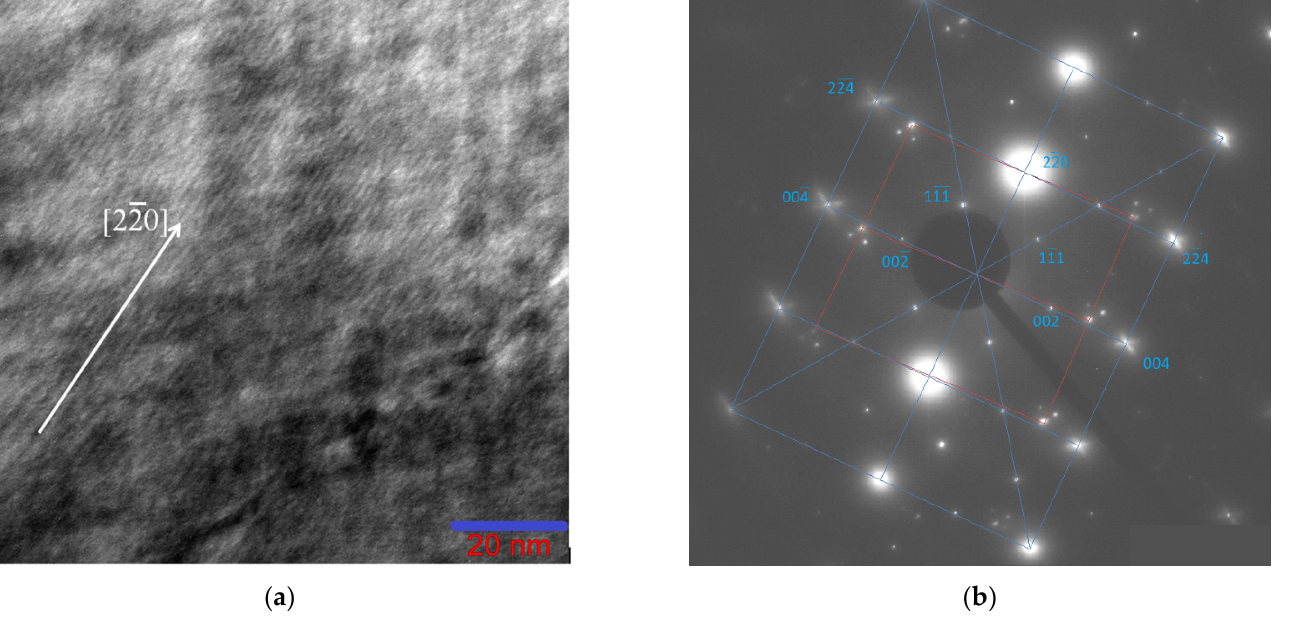
Figure 5. Bright-field ( a ) TEM image of the Ni 46 Mn 41 In 13 alloy in the austenitic state at room temperature and the corresponding microelectron diffraction pattern ( b ) obtained from the entire area. The grating L2 1 is shown in blue, with the [110] zone axis.